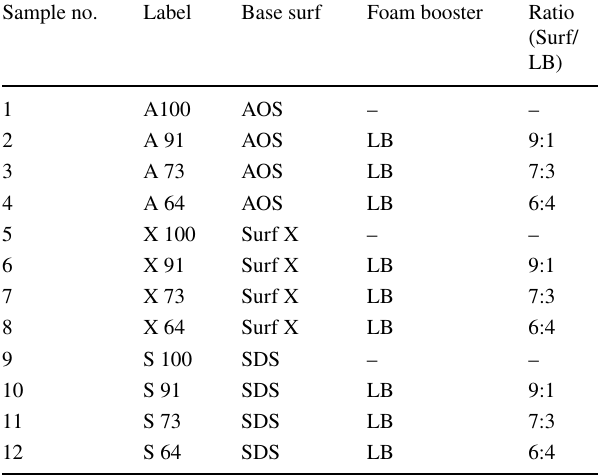
Table 1 Surfactant solutions and LB blend used in the experiments Sample